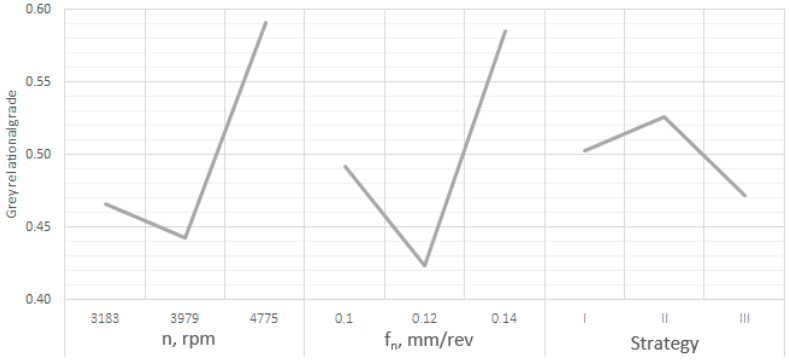
Figure 7. Response graph for mean Grey relational grade.